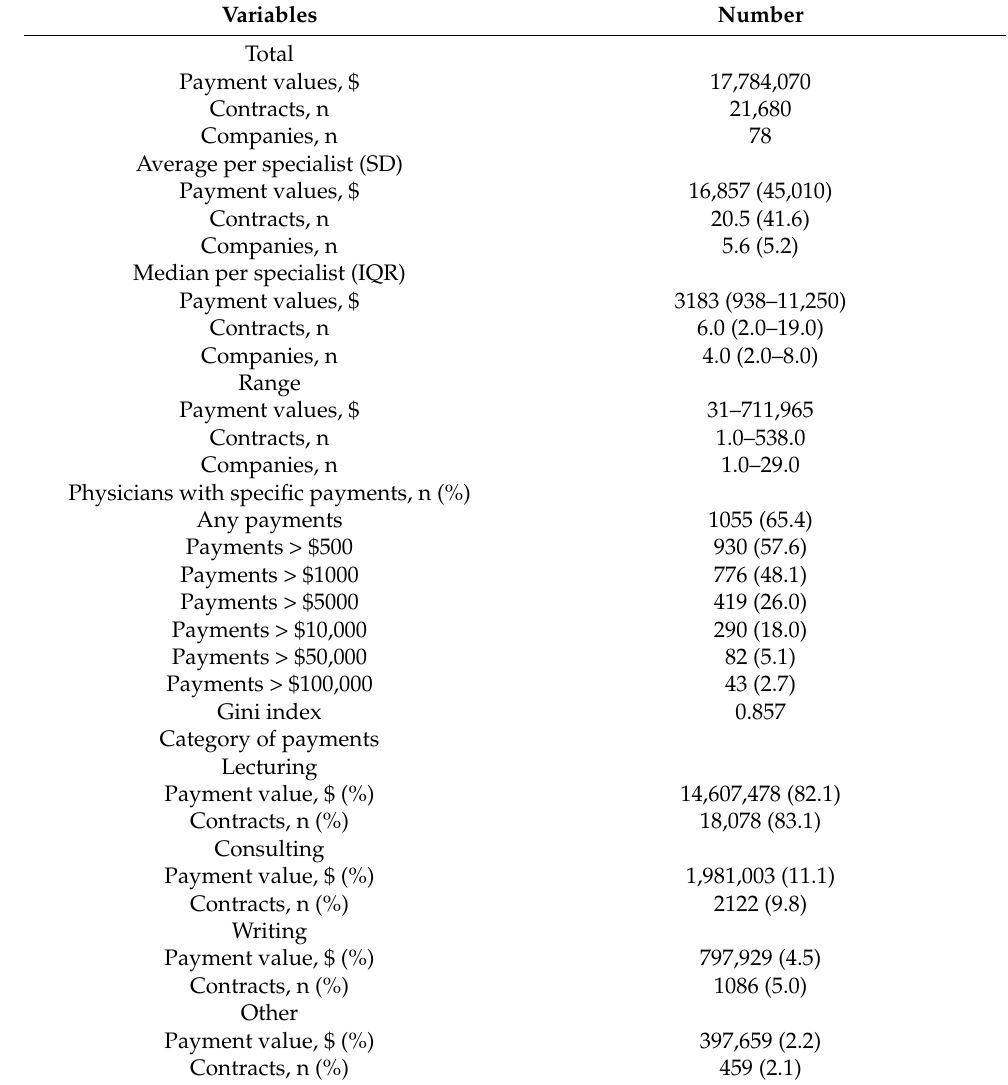
Table 1. Summary of personal payments from Japanese pharmaceutical companies to infectious disease specialists certified by the Japanese Association for Infectious Disease between 2016 and